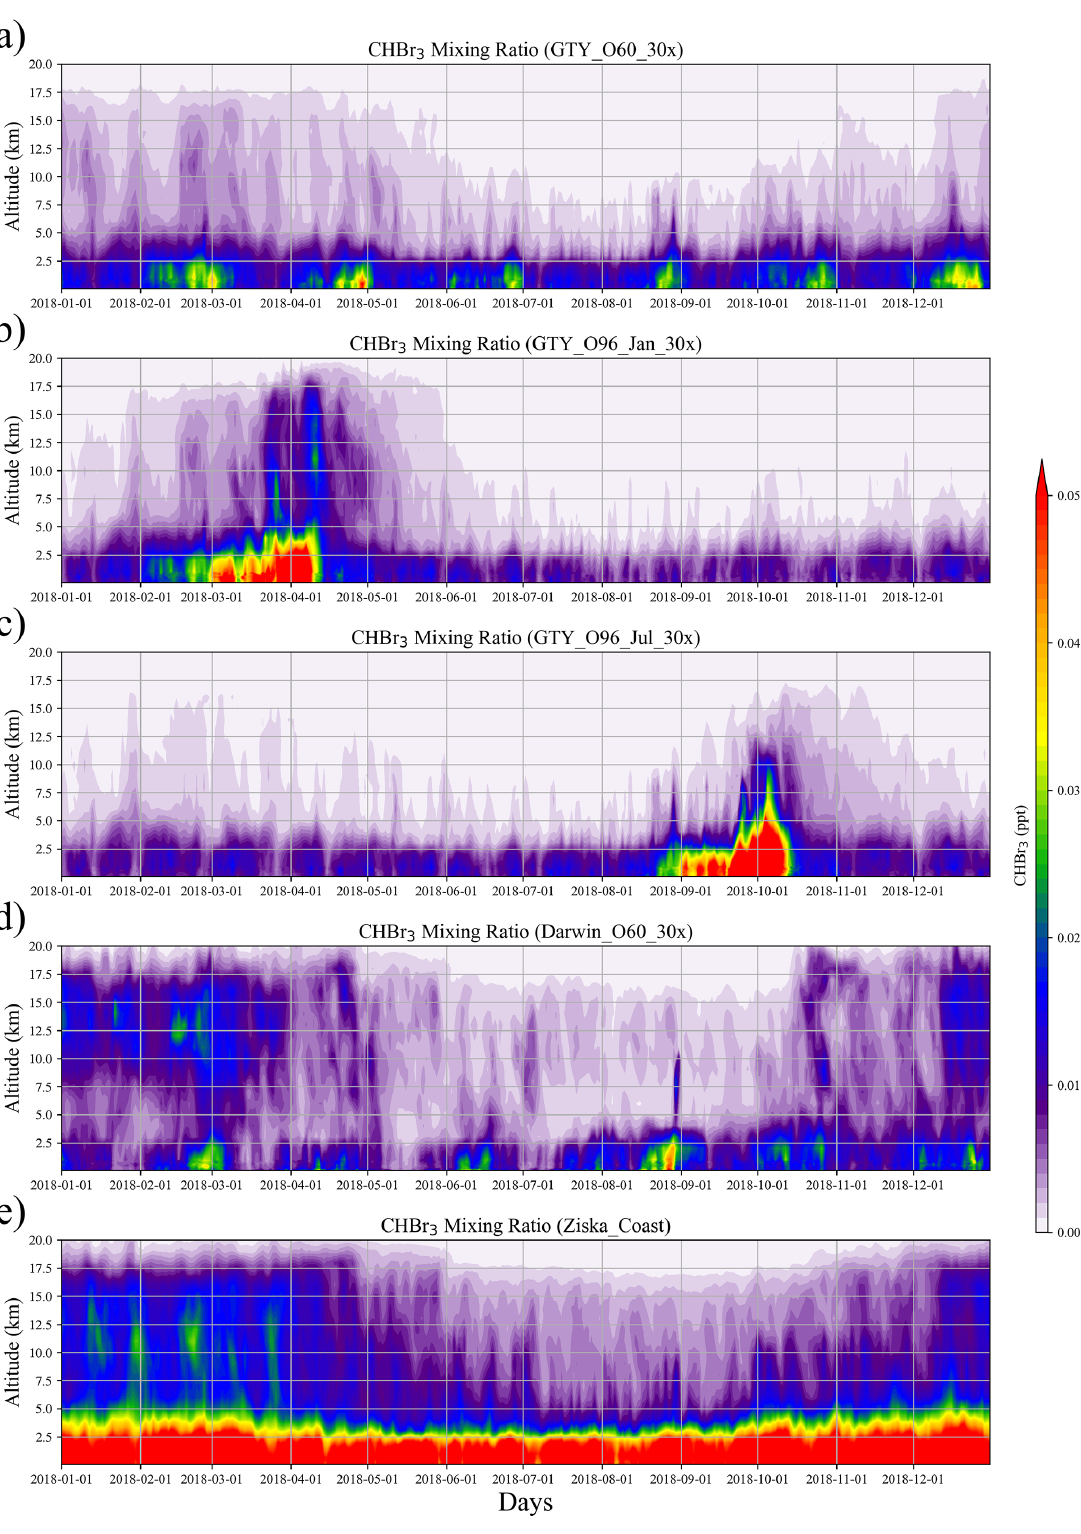
Figure 4. Altitude–time cross sections of CHBr 3 mixing ratio averaged over 10–45 ◦ S, 105–165 ◦ E from global scenarios (a) GTY_O60_30x, (b) GTY_O96_Jan_30x, (c) GTY_O96_Jul_30x, and (d) Darwin_O60_30x and background scenario (e)